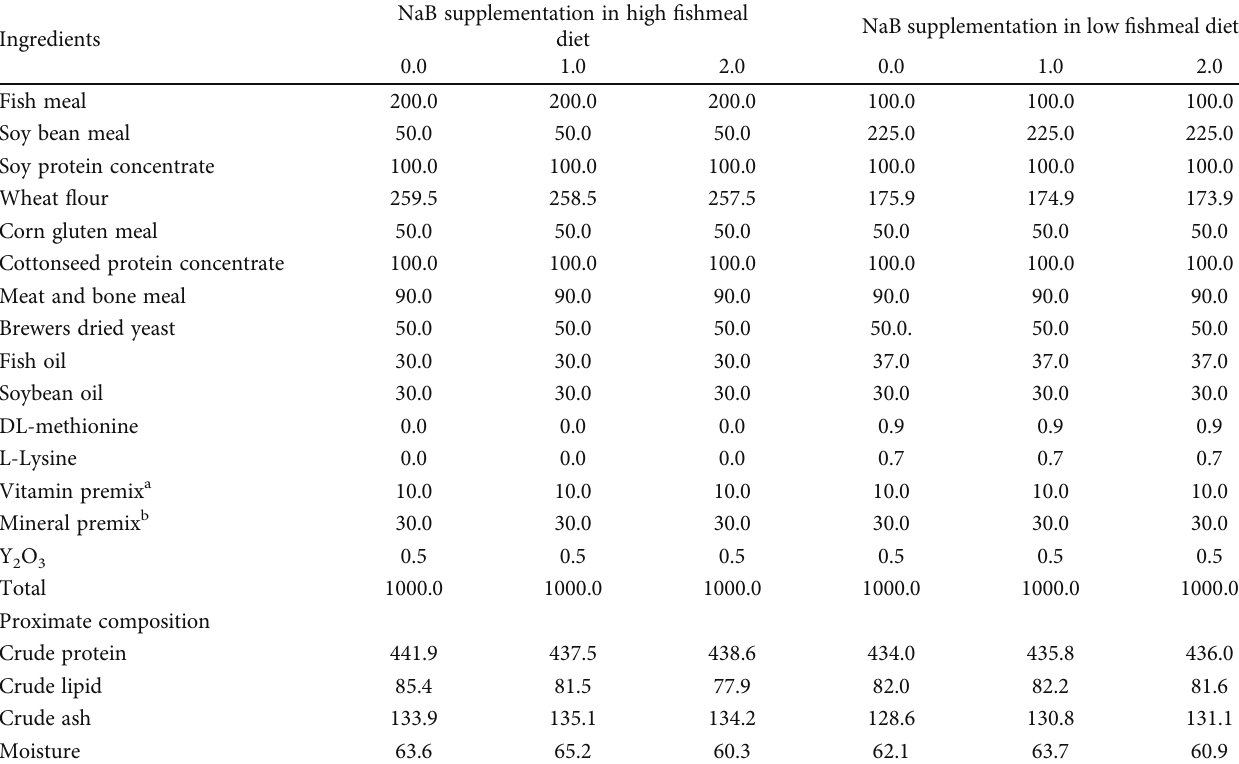
Table 1: The formulation and proximate composition of experimental diets (air dry basis,